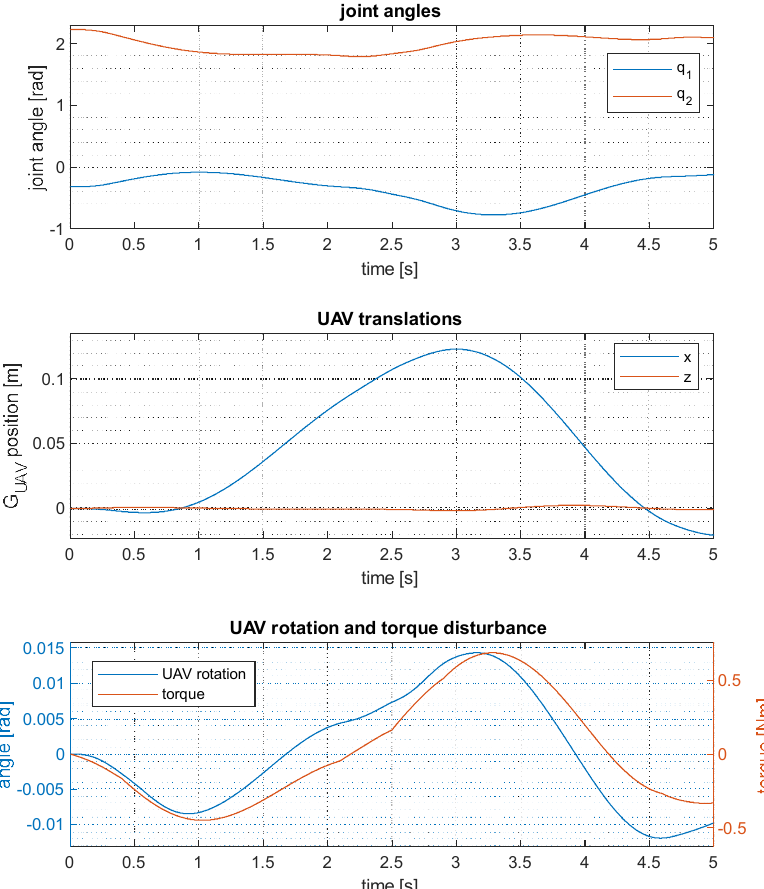
Figure 11. Manipulator ( top ) and UAV motions and torque disturbance ( middle and bottom ) for the 2-DOF UAM using the generalized Jacobian with external forces.